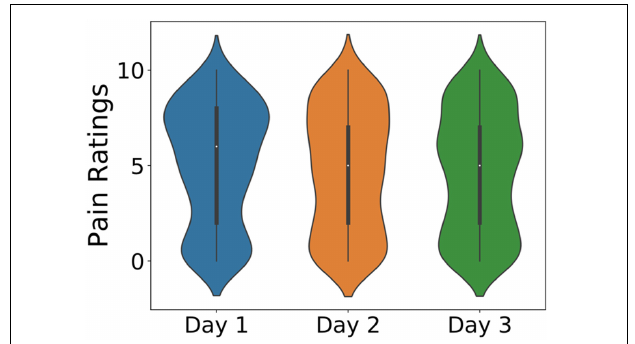
FIGURE 4 | The subjective ratings from three repeated days of all the subjects.